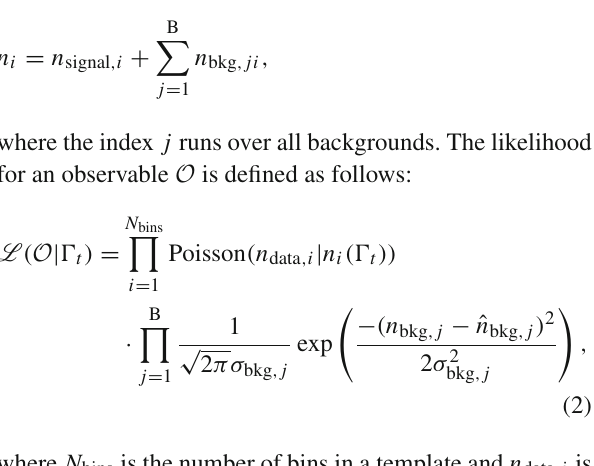
thehadronicallydecaying W boson,intherange0 . 7 ≤ (cid:3) t ≤ 3 . 0GeVin the muon+jets channel for events with at least two b -tags in the | η | > 1 region. The lower panel shows the ratio of the templates with varied (cid:3) t to the nominal template generated for a decay width of (cid:3) t = 1 . 33